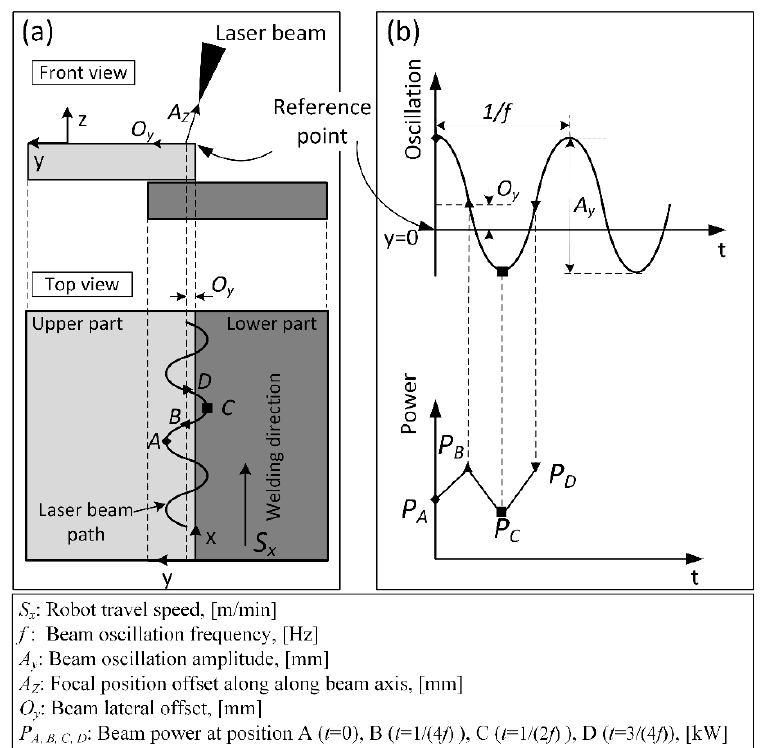
Figure 1. Illustration of key welding parameters. ( a ) Front view and top view showing the laser beam path; and ( b ) representation of beam oscillation and power modulation as function of time.